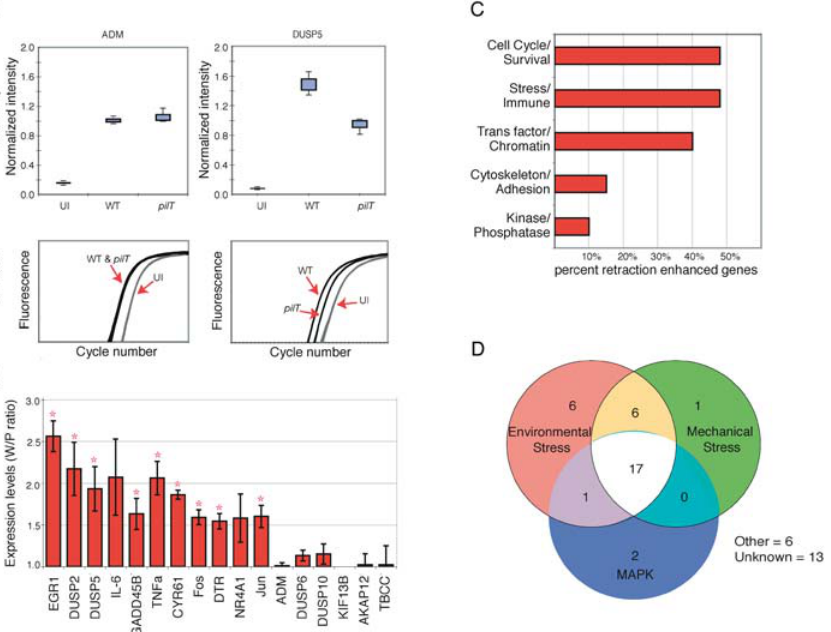
Figure 2. Real-Time Quantitative RT-PCR Verification of Microarray Results and Initial Characterization of Retraction-Enhanced Genes (A) Microarray (top panels) and real-time quantitative RT-PCR (bottom panels) expression profiles of ADM and DUSP5 in uninfected cells (UI), N400-infected cells (WT), and N400 pilT -infected cells (pilT) . Microarray data are shown as box-plots ( n = 3). RT-PCR data are plotted as triplicate samples from one representative experiment. (B) Real-time quantitative RT-PCR verification of retraction-enhanced expression of selected genes. Data are expressed as average W/P ( 6 SEM, n = 3). Genes with a W/P statistically greater than 1.0 ( p , 0.05) are denoted with an asterisk. (C) Grouping of retraction-enhanced genes according to function, based on published reports (see Table S1). Some genes have multiple functions and thus appear in more than one group. (D) Genes in this study that are known to be induced by environmental stress, mechanical stress, or MAPK signaling (see Table